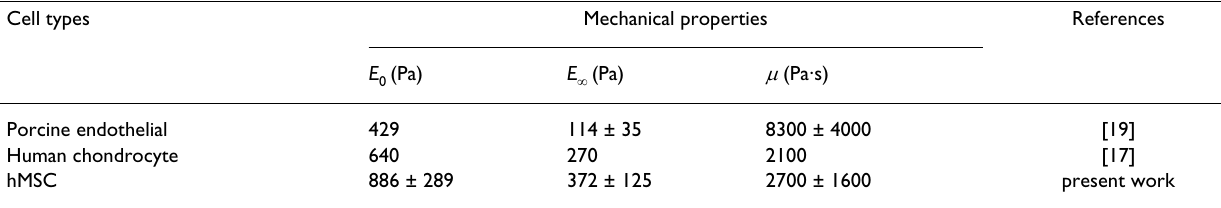
Table 1: The comparison of mechanical properties obtained for various cells Cell